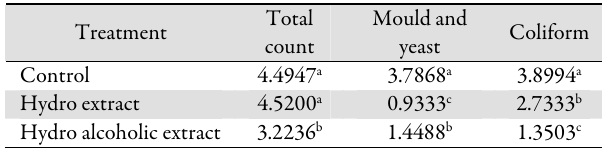
Tab. 4. Mean squares of microbial load of the studied medicinal plants